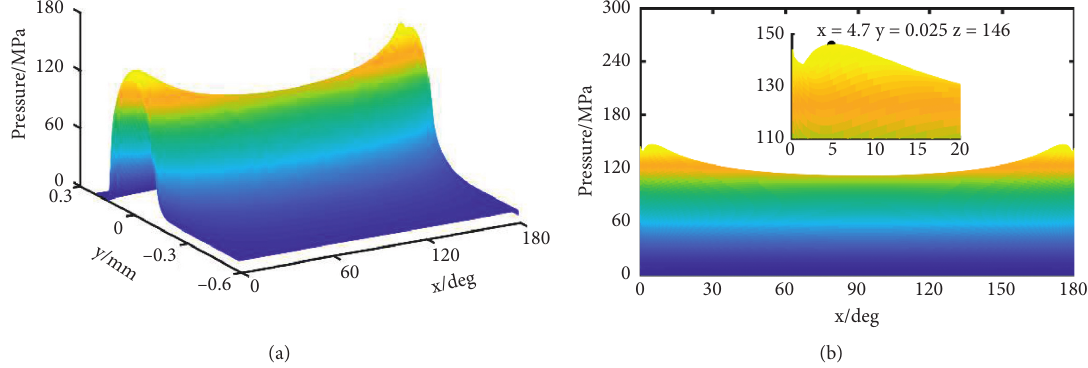
Figure 5: The pressure distribution of PRCB at n � 700 r/min p � 10MPa. (a) 3D diagram of oil film pressure distribution. (b) Right view of oil film pressure distribution.